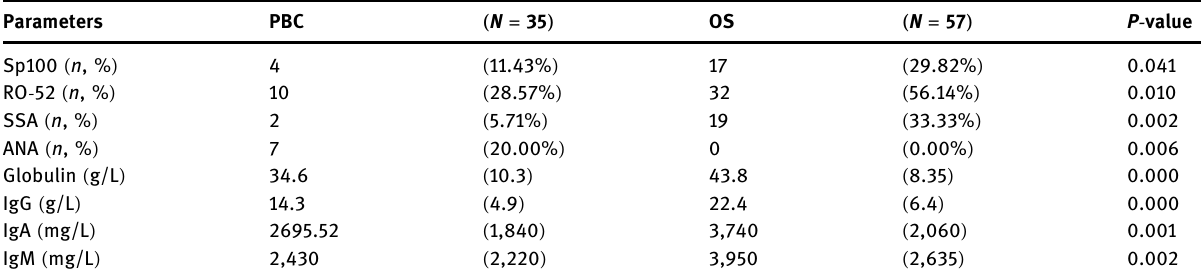
Table 3: Comparison between PBC and OS